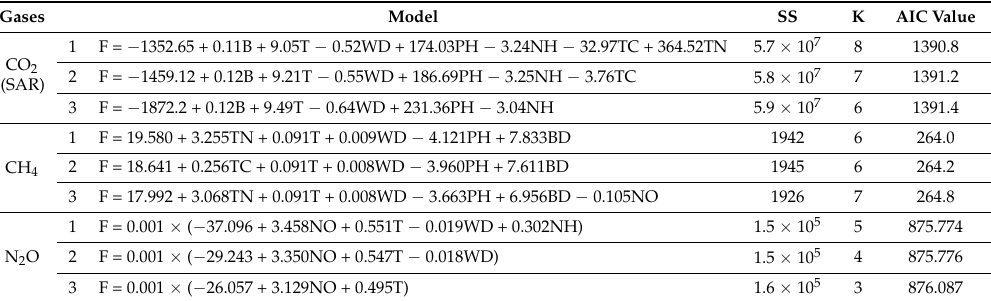
Table 3. Model selection for the daily flux simulation. Only the best three models were shown. F: